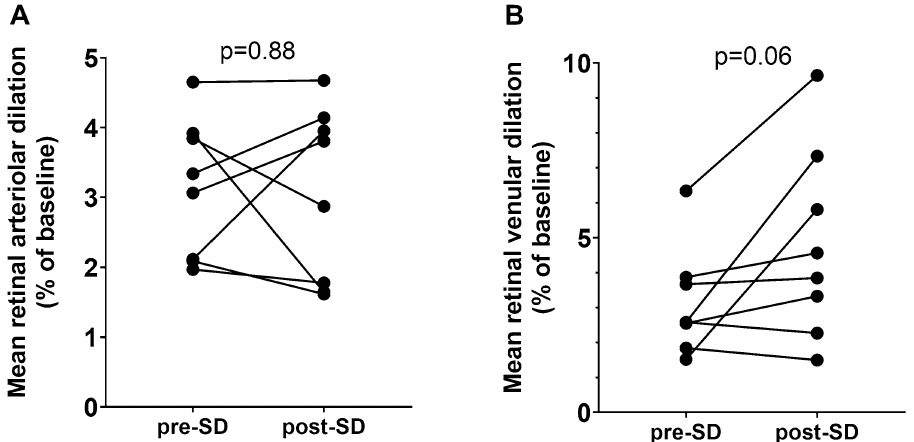
Figure 6. The effect of sleep deprivation on NVC-related hemodynamic responses measured in retinal arterioles and venules in responses to flicker light photoreceptor stimulation. Flicker light photoreceptor stimulation was used during Dynamic retinal Vessel Analysis (DVA) assessments to evoke NVC in retinal vessels. No statistically significant effect of sleep deprivation was observed in evoked retinal arteriolar dilation (panel A). Note the SD tends to alter flicker light-induced retinal venular dilation (panel B). Paired t -test was used for comparisons. p < 0.05 was considered